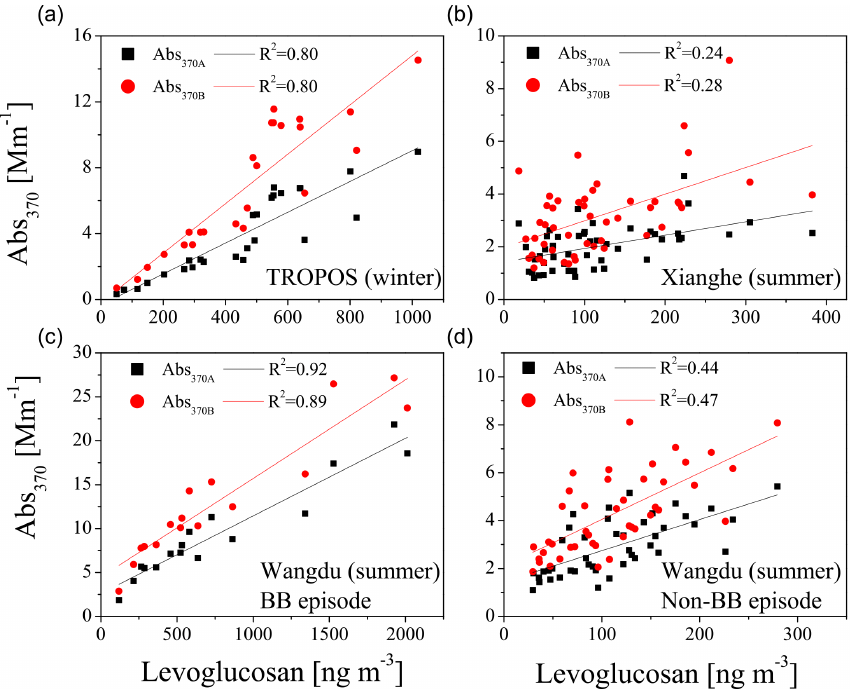
Figure 2. Scatter plot of the aqueous light absorption coefficient Abs 370 with levoglucosan concentration for the campaigns (a) TROPOS (winter,), (b) Xianghe (summer), (c) Wangdu (summer, BB episode) and (d) Wangdu (summer, non-BB episode). Abs 370 is given for acidic conditions (indicated by the subscript “A”, black squares) and for alkaline conditions (indicated by the subscript “B”, red dots). Note different axis